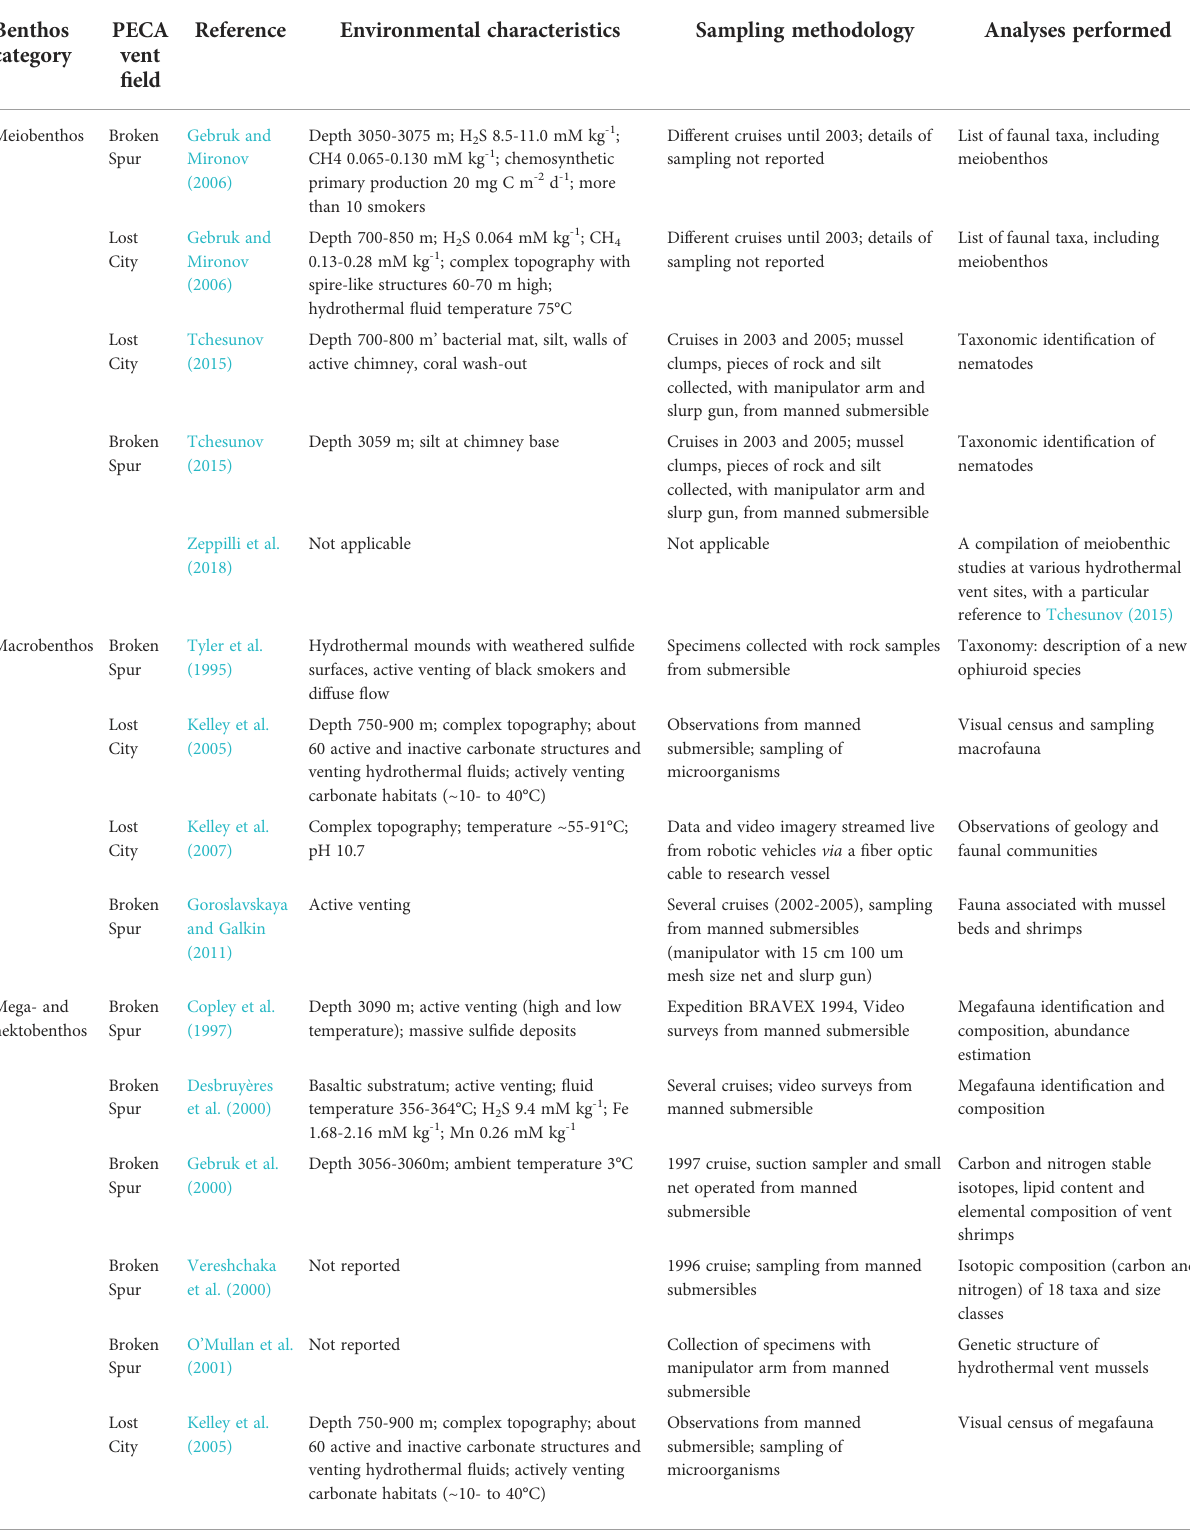
TABLE 1 A summary of data sources on the PECA benthos (environmental characteristics, sampling methodology when reported, and analyses